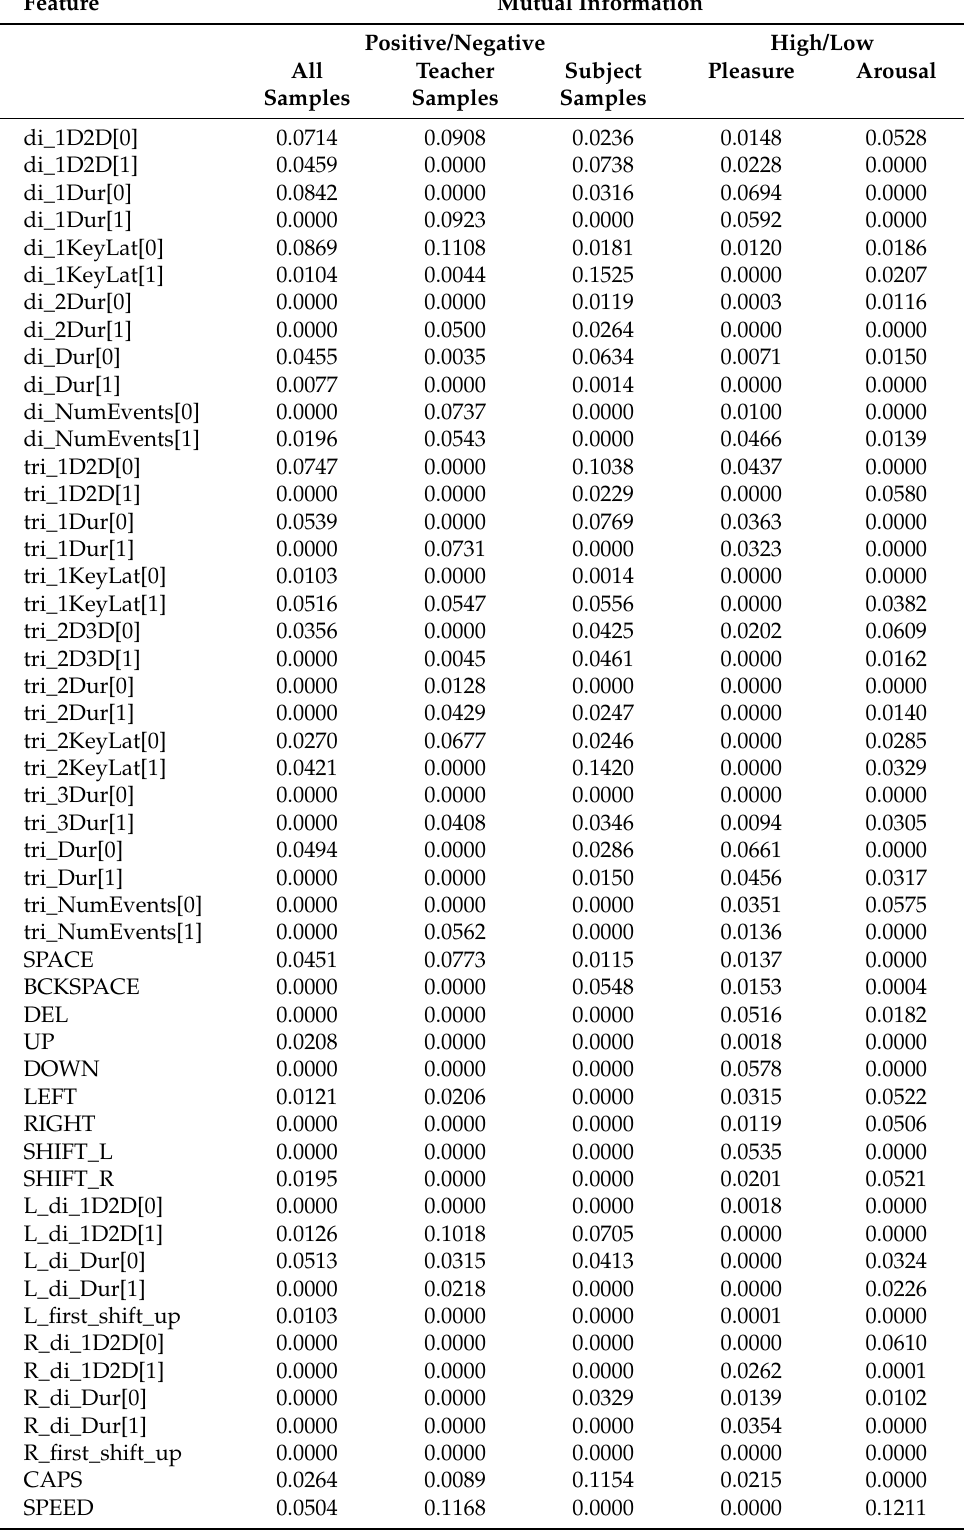
Table 5. Evaluation of keyboard patterns features—mutual information